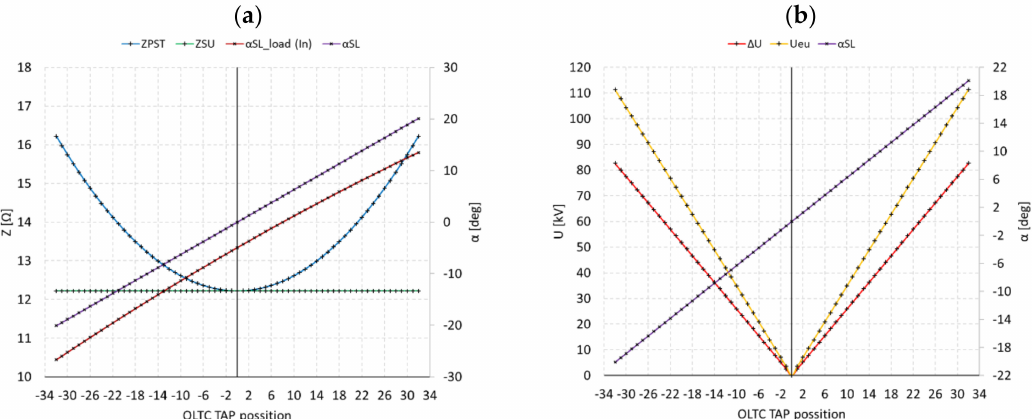
Figure 17. Total range ( a ) PST impedance and phase shift adjustment for no- and on-load condition with reflecting to ( b ) EU regulation voltage parameters and quadrature voltage.